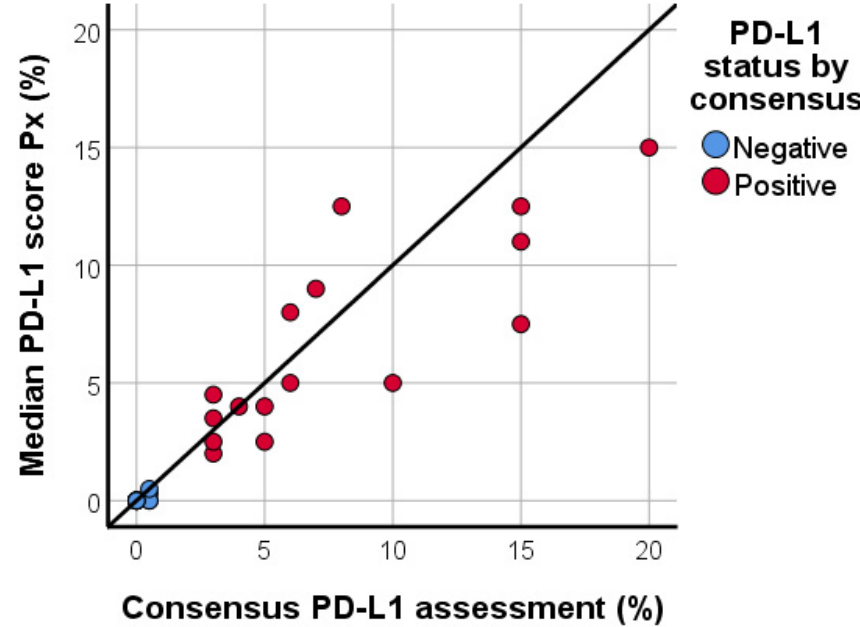
Figure 3. Scatter plot, illustrating the median PD-L1/SP142 score based upon the assessment by